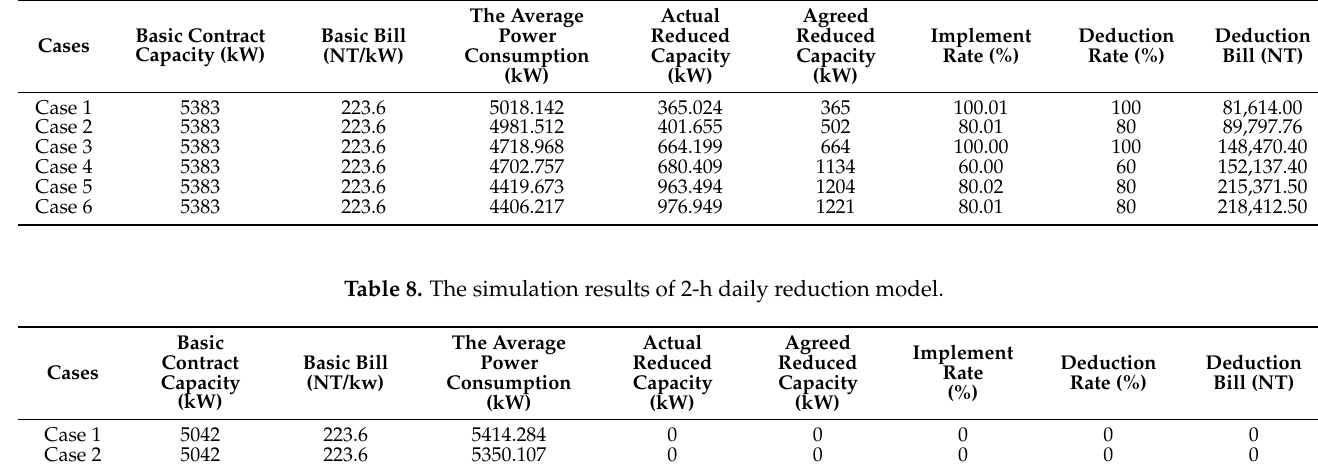
Figure 5. The power consumption of air-conditioner per hour in August 2020. Table 7. The simulation results of 6-h daily reduction model.